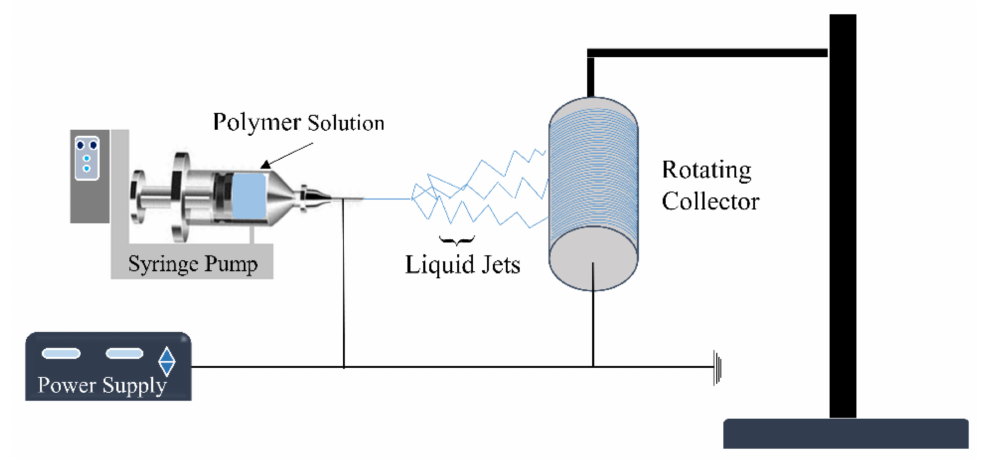
Figure 2. Schematic of electrospinning